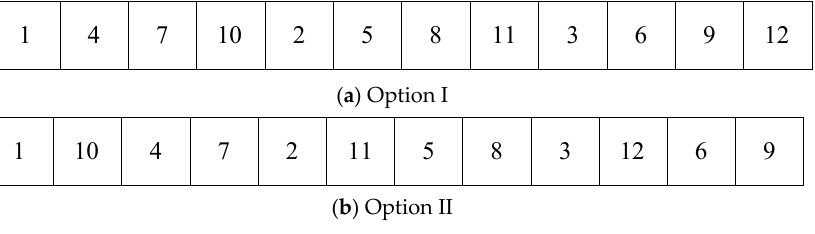
Figure 7. Simulation test plan. Table 3. Mechanical parameters of the rock mass.